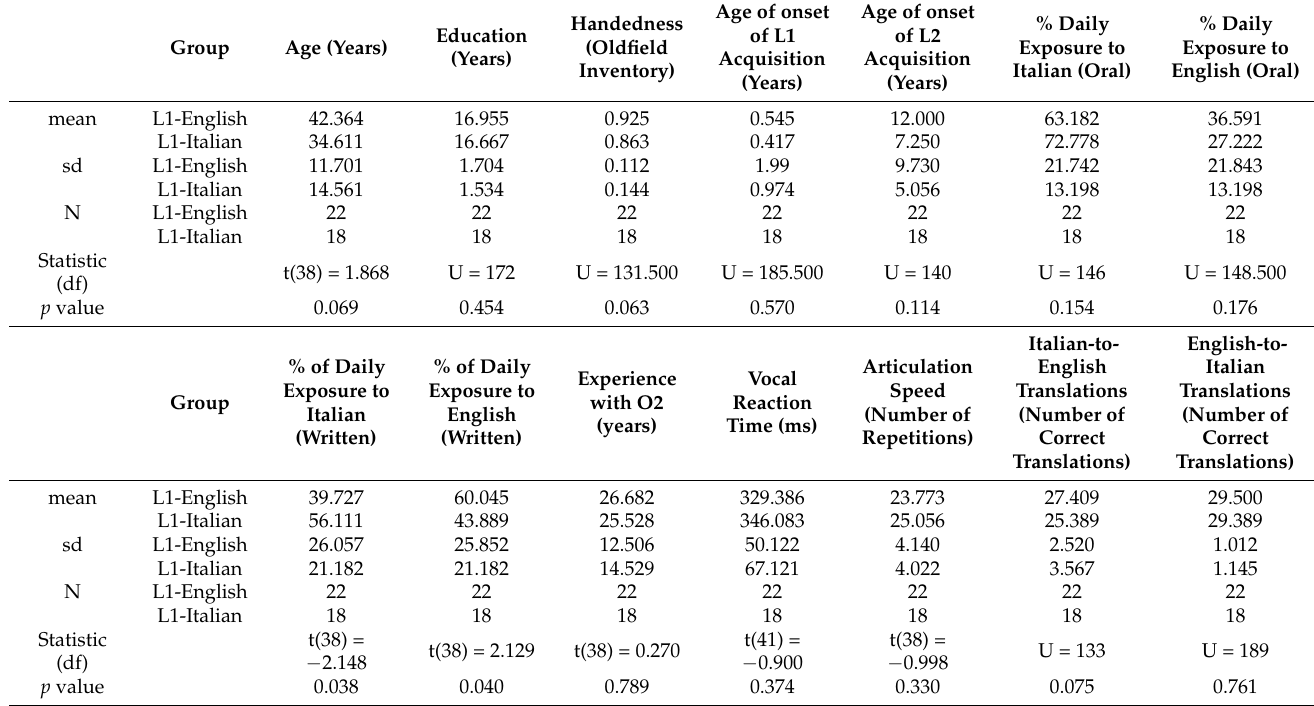
Table 1. Demographic data and information on bilingual experience of the participants: age and education (years); handedness (evaluated using the Oldfield inventory); age of onset of acquisition of first and second language (spoken; years); percentage of daily oral and written exposure to either Italian or English (based on self-reports made by the participants); experience with second orthography (O2, years); vocal reaction times to a simple visual stimulus (in milliseconds [ms]); articulation speed (number of repetitions of a target pair of words in 15 s); number of correct Italian-to-English and English-to-Italian translations (30 words of high, intermediate, and low frequency for either language as in [35]). For further details, see the Materials and Methods section and Supplementary